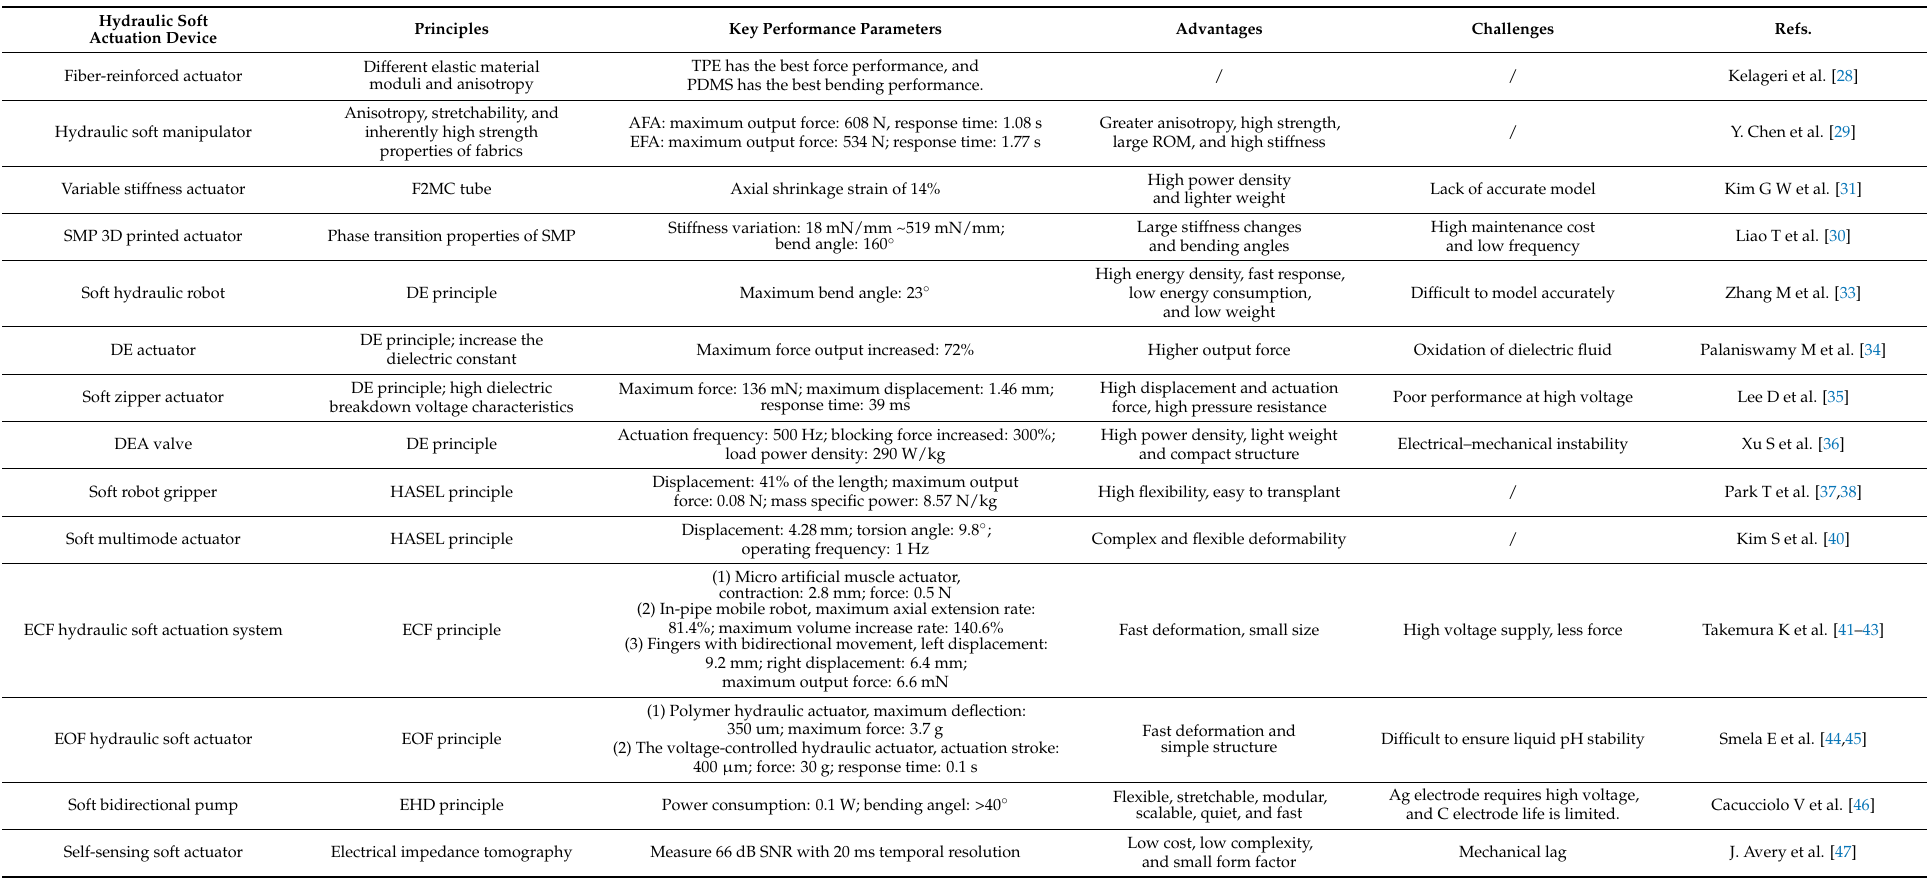
Table 2. Summary of hydraulic soft actuator based on